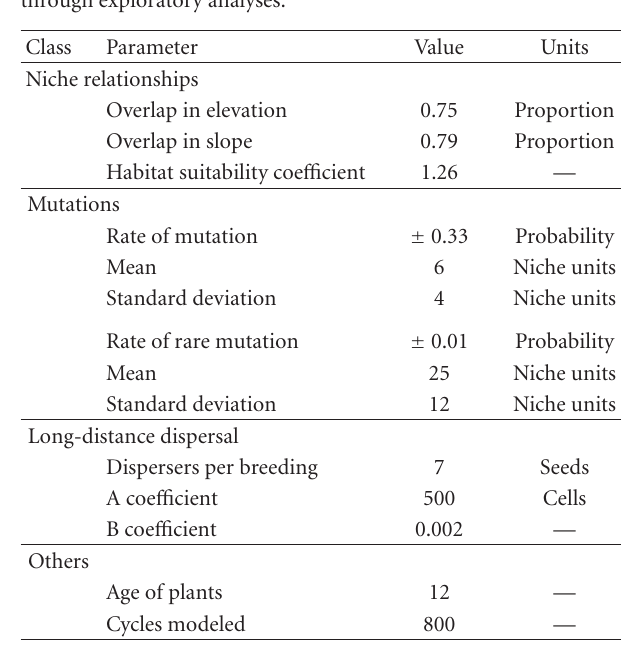
Table 1: A summary of the parameters in the model, grouped into classes, their values, and their units. Values used were determined through exploratory